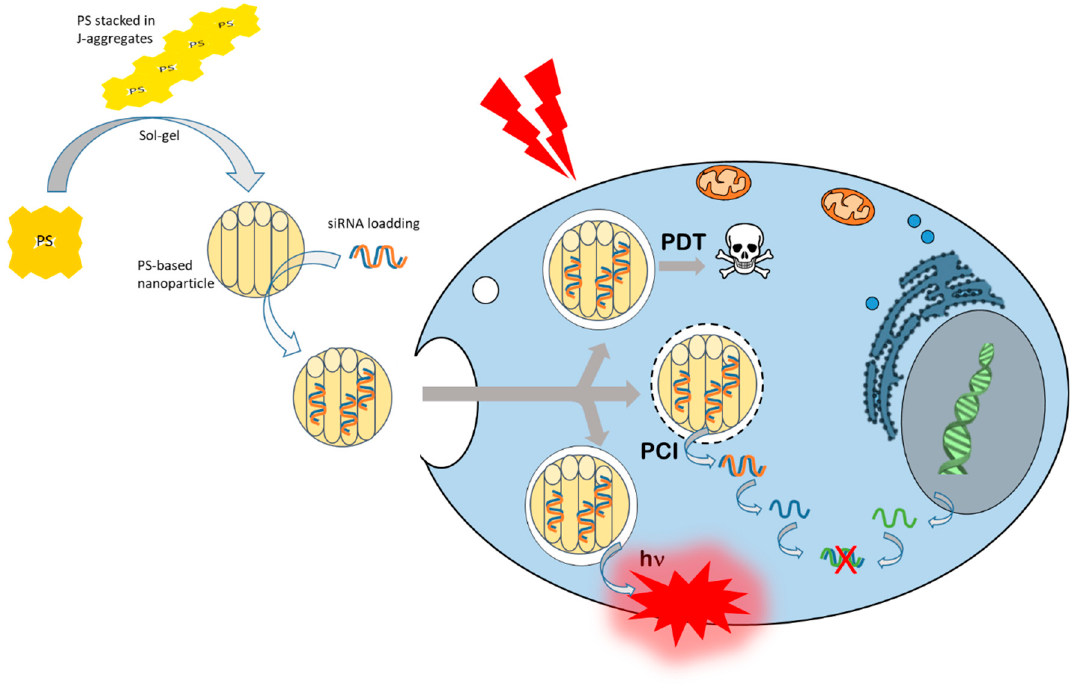
Figure 3. PMO synthesis and siRNA loading for cancer cell internalization, and two-photon excitation induced photodynamic therapy (PDT),photochemical internalization (PCI), and imaging (h ν ).